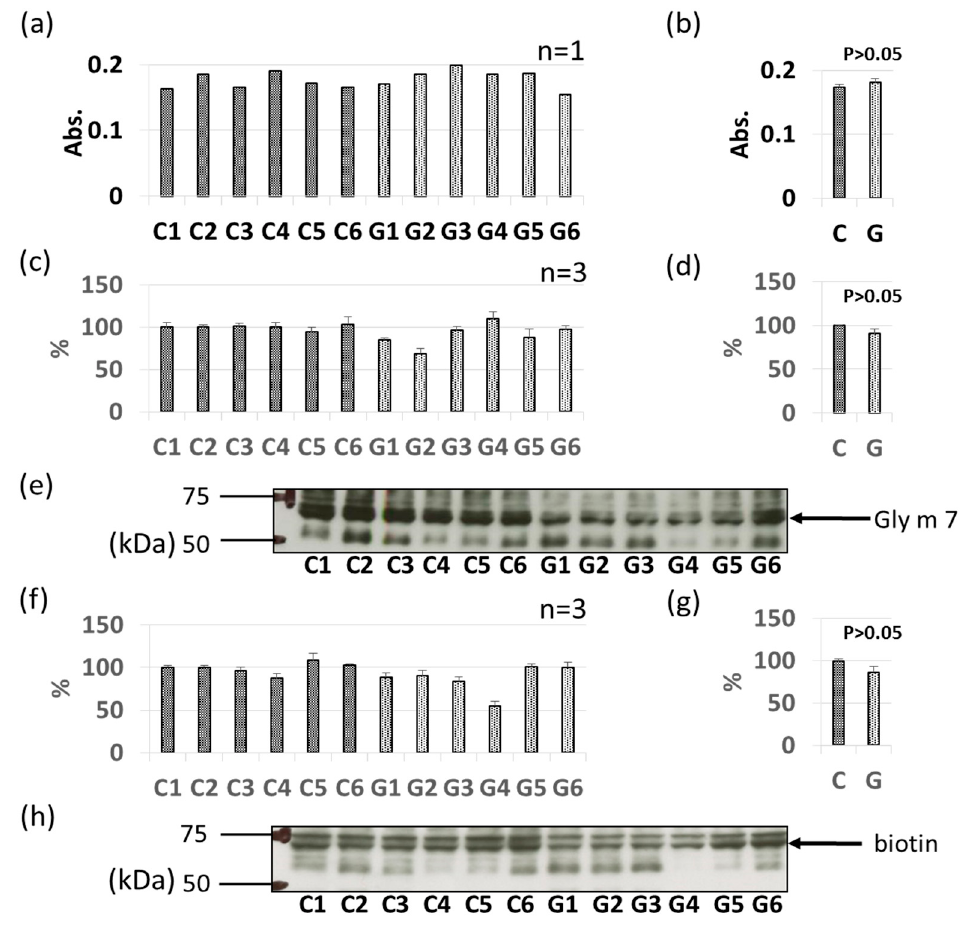
Figure 9. Comparison of Gly m 7 levels in GM-and non-GM soybeans by ELISA (a,b) and immunoblotting (c–h) . Soybean protein extracts were evaluated by ELISA (a,b) and immunoblotting (c–h) for detection of Gly m 7 levels. The ELISA data are presented in absorbance values (Abs). Immunoblotting for Gly m 7 levels was performed using a rabbit-derived peptide-antibody (c–e) and streptavidin–HRP for the biotin moiety of Gly m 7 (f–h) . The individual data from six GM-and non-GM soybeans (c,f) are presented as the mean ± SD of three independent replicates. The collated data (b,d,g) are presented as the mean ± SD of all individual data points from the control (C1–C6, six non- GM soybeans) or experimental (G1–G6, six GM soybeans) groups relative to the value of control number 1 (C1). Representative detections are also provided (e,h) . ELISA and immunoblotting were